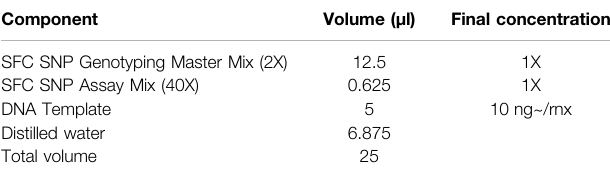
TABLE 2 | Assay setup for the SNP genotyping